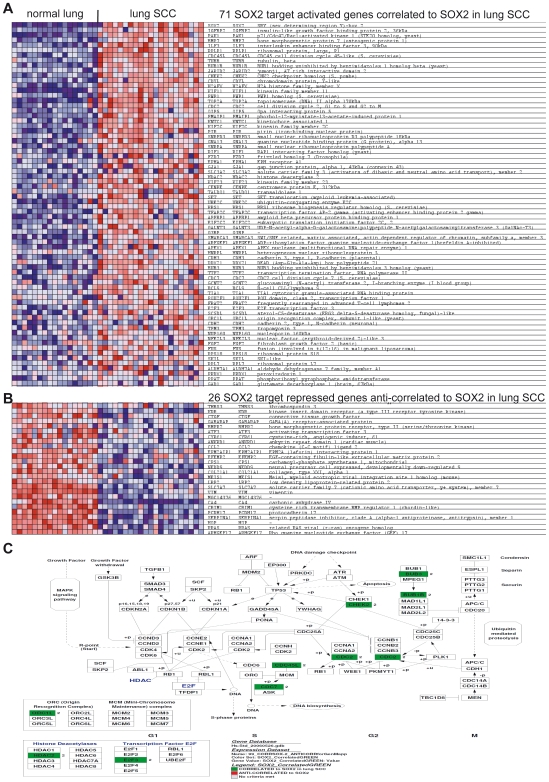
List of known direct SOX2 targets in hESCs that significantly correlate and anti-correlate to with SOX2 expression in lung SCCs.
A. The 71 genes that are known SOX2-activated target genes in human ESCs and significantly correlate with SOX2 expression in lung SCCs. B. The 26 genes that are known SOX2-repressed target genes in human ESCs and significantly anti-correlate with SOX2 expression in lung SCCs. Panels A and B: For each gene in each sample, expression is represented by a square with a color that codes for the level as a gradient (dark blue, low expression, to dark red, strong expression). C. Genmapp view of the enriched cell cycle regulators that are targets of SOX2 in hESCs and correlate with SOX2 expression in lung SCCs. Green boxes represent the genes that are significantly enriched among the known SOX2-activated target genes in human ESCs and correlate to SOX2 expression in lung SCCs.